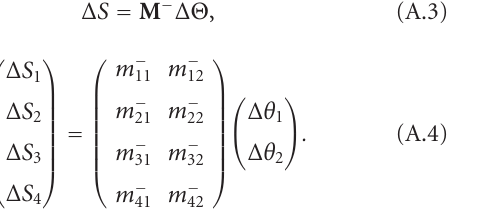
Figure 12: Skeletal model structure of the upper